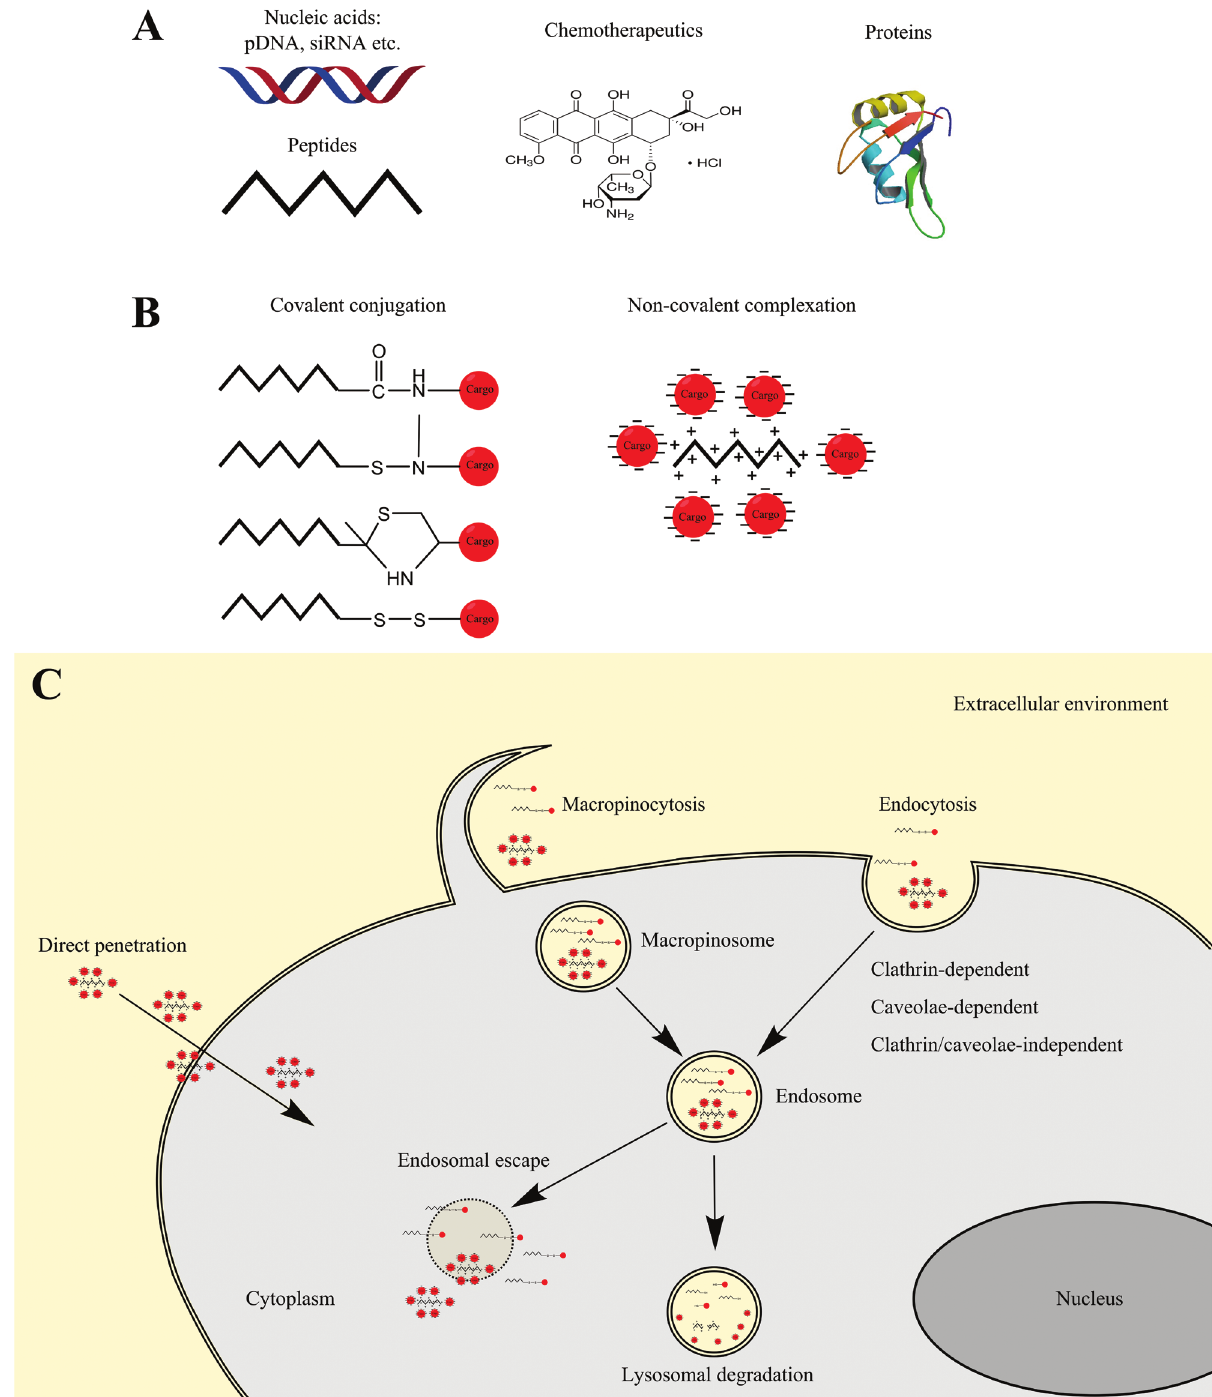
Figure 1 Different strategies for peptide-mediated delivery and mechanisms of internalization of CCPs. Peptide and different possible cargo (A). Covalent and non-covalent strategies for conjugation/complexation of CPP with cargo molecule (B). CPPs or CPP/cargo complexes bind to extracellular matrix via the proteoglycan on the cell surface, increase of membrane fluidity or microdomain dynamic promotes the cell entry and release in the cytosol of CPP non-covalently complexed and of CPP covalently conju- gated via membrane fusion or cellular uptake of CPP via endocytosis pathway (•clathrin-dependent, •caveolae-dependent, • clathrin- and caveolae-independent) or macropinocytosis. After endocytic capture, CPPs can escape from lysosomal degradation and enter the cytosol and the nucleus, remain in the endosomes, or be delivered in the Golgi apparatus and the endoplasmic reticulum